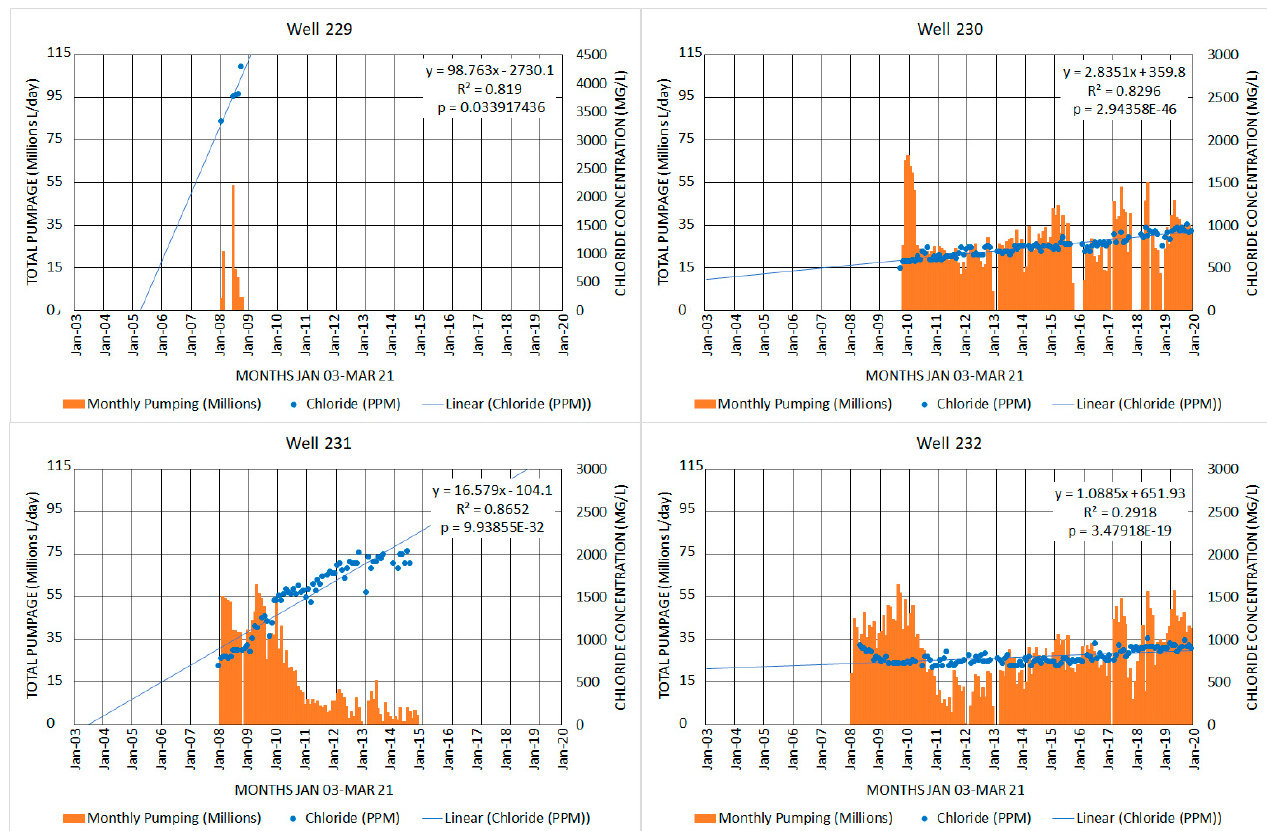
Figure 13. Monthly cumulative pumpage and dissolved chloride concentration versus time with a linear regression trend line.